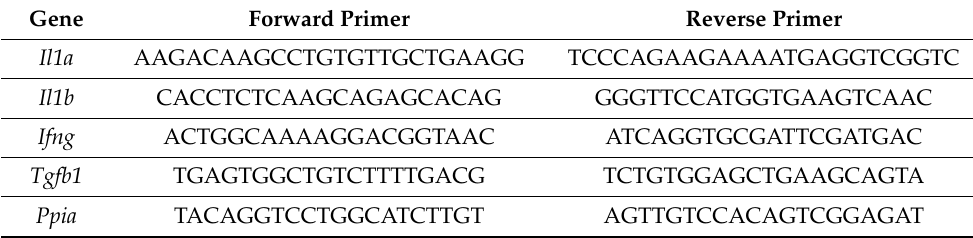
Table 1. List of primers used in RT-PCR